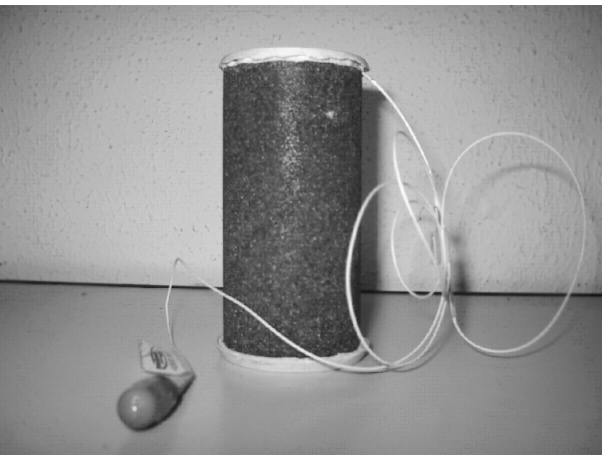
Figure 2. Specimen made with recycled sand. Figure 3. Experimental